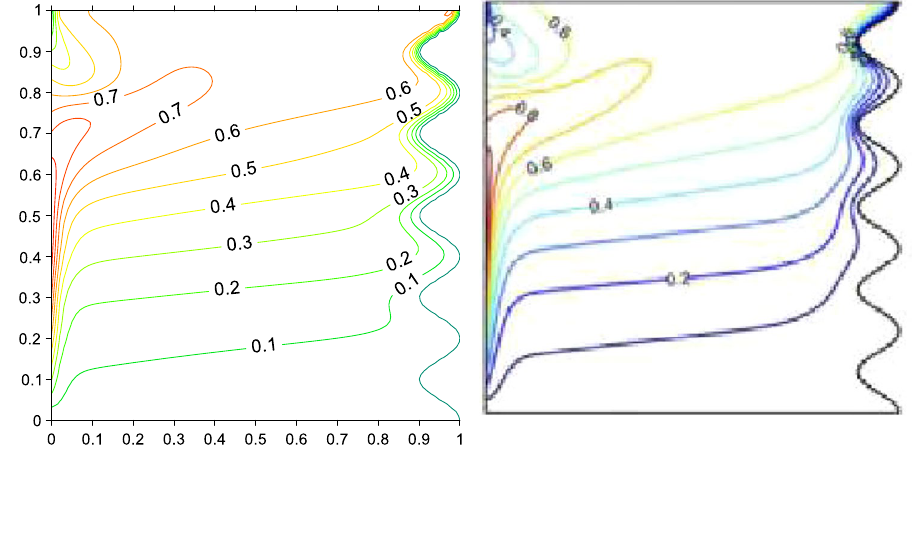
Table 2 Comparisons of the horizontal velocity with those of Khanafer and Chamkha [75] at Gr = 100 and Pr = 0.71, 𝜙 = 0 %